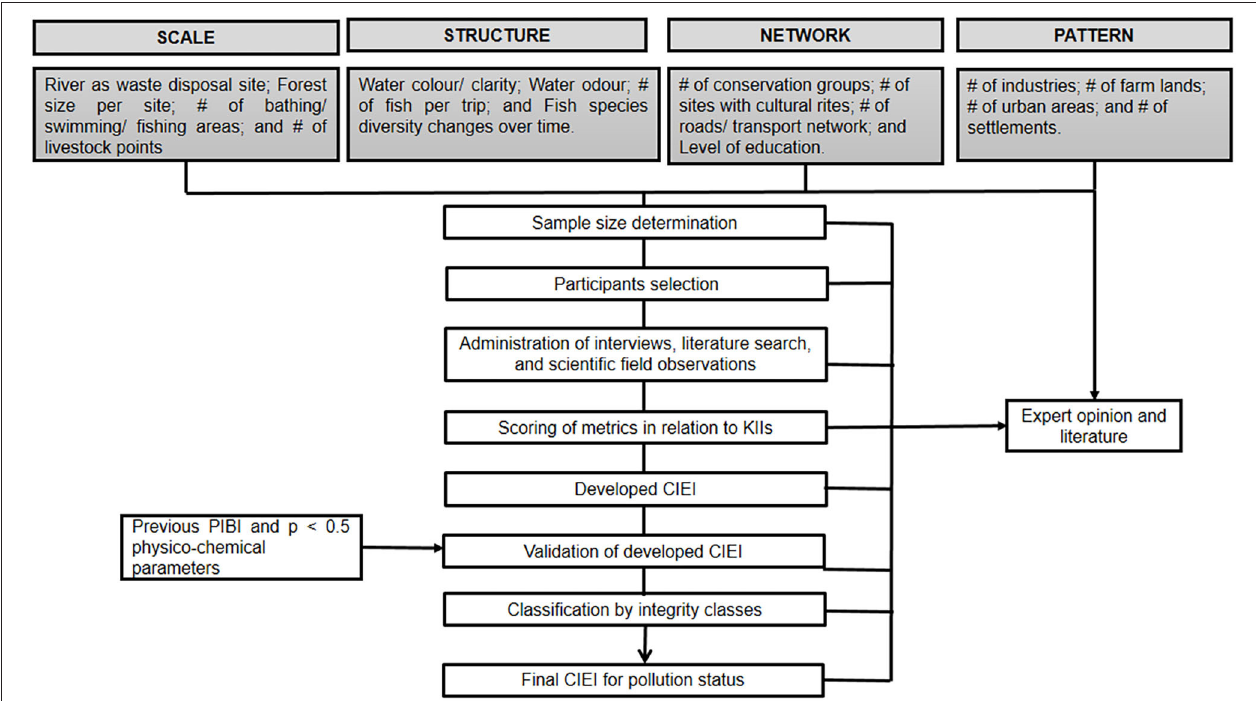
FIGURE 2 | Flow chart showing the steps involved in the development of the Citizen Index of Ecological Integrity (CIEI) novelty for assessing the pollution status of major river catchments in Lake Victoria, Kenya.